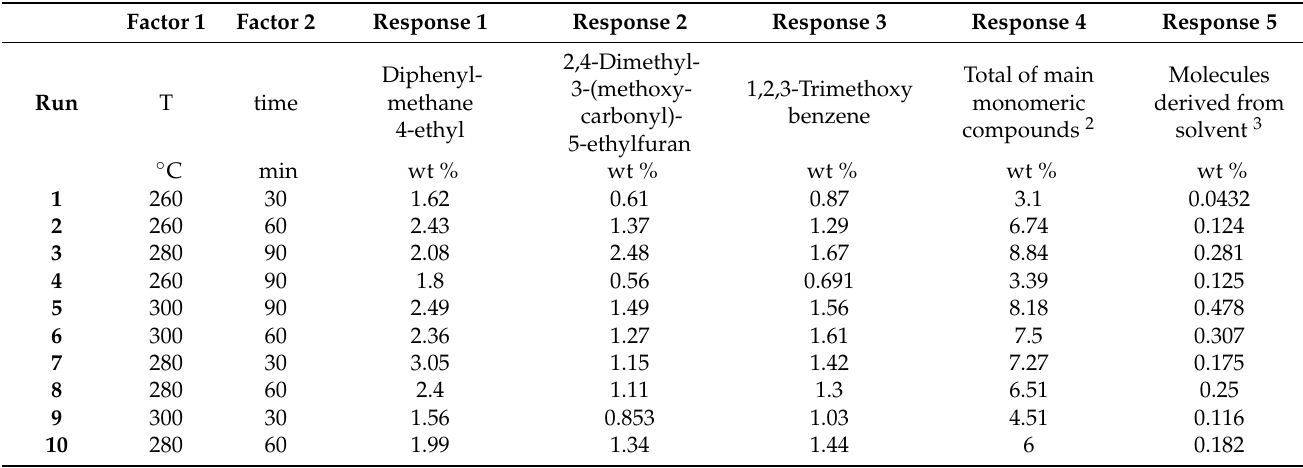
1 Calculated as (weight of monomer/weight of loaded lignin) × 100. The weight of the monomer is determined by its concentration × the volume of liquid phase. 2 Contains also guaiacol, syringol, p-ethylguaiacol, 2-metossi, 4-propyl phenol. 3 Butyl butanoate, 2-ethyl-2-hexenal, 2-ethyl-1-hexanol,